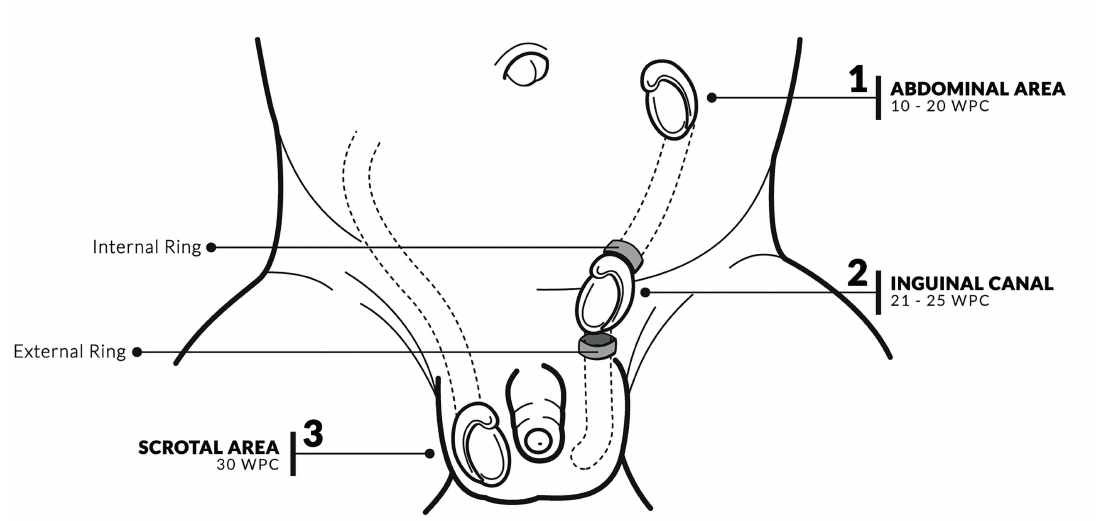
Figure 1 - Schematic drawing showing the testicular migration during human fetal period. We can observe the testis situated in abdominal position between 10 and 20 weeks post conception (WPC) (1); in inguinal position (testis situated between internal and external inguinal rings) during 21 and 25 WPC (2) and in scrotal position after the 30WPC